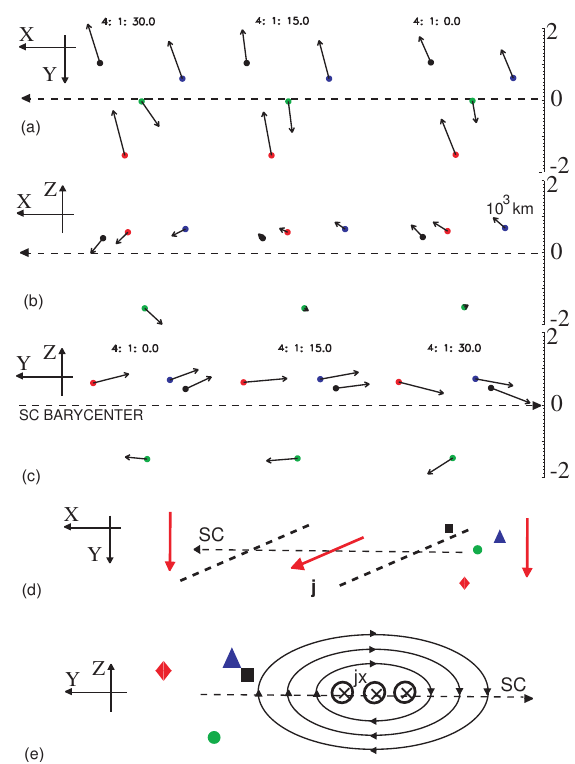
Fig. 14. Interval C : Projections of the magnetic field at the four s/c (black arrows) onto XY (a) , XZ (b) , and YZ GSM planes at the three successive instances. Note, that time increases from right to left in panels (a) and (b), and from left to right in panel (c) , according to the spacecraft pass (dashed arrow) through the structure. Panels (d) and (e) present the interpretation scheme. Red arrows in panel (d) indicate the electric current direction.